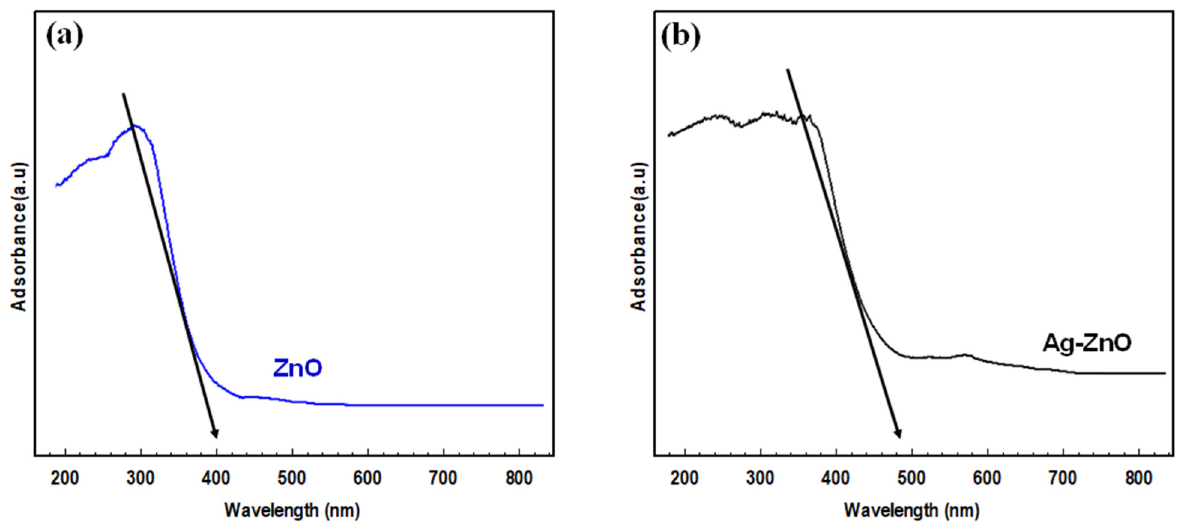
Figure 5. UV-vis spectra of ( a ) ZnO and ( b )